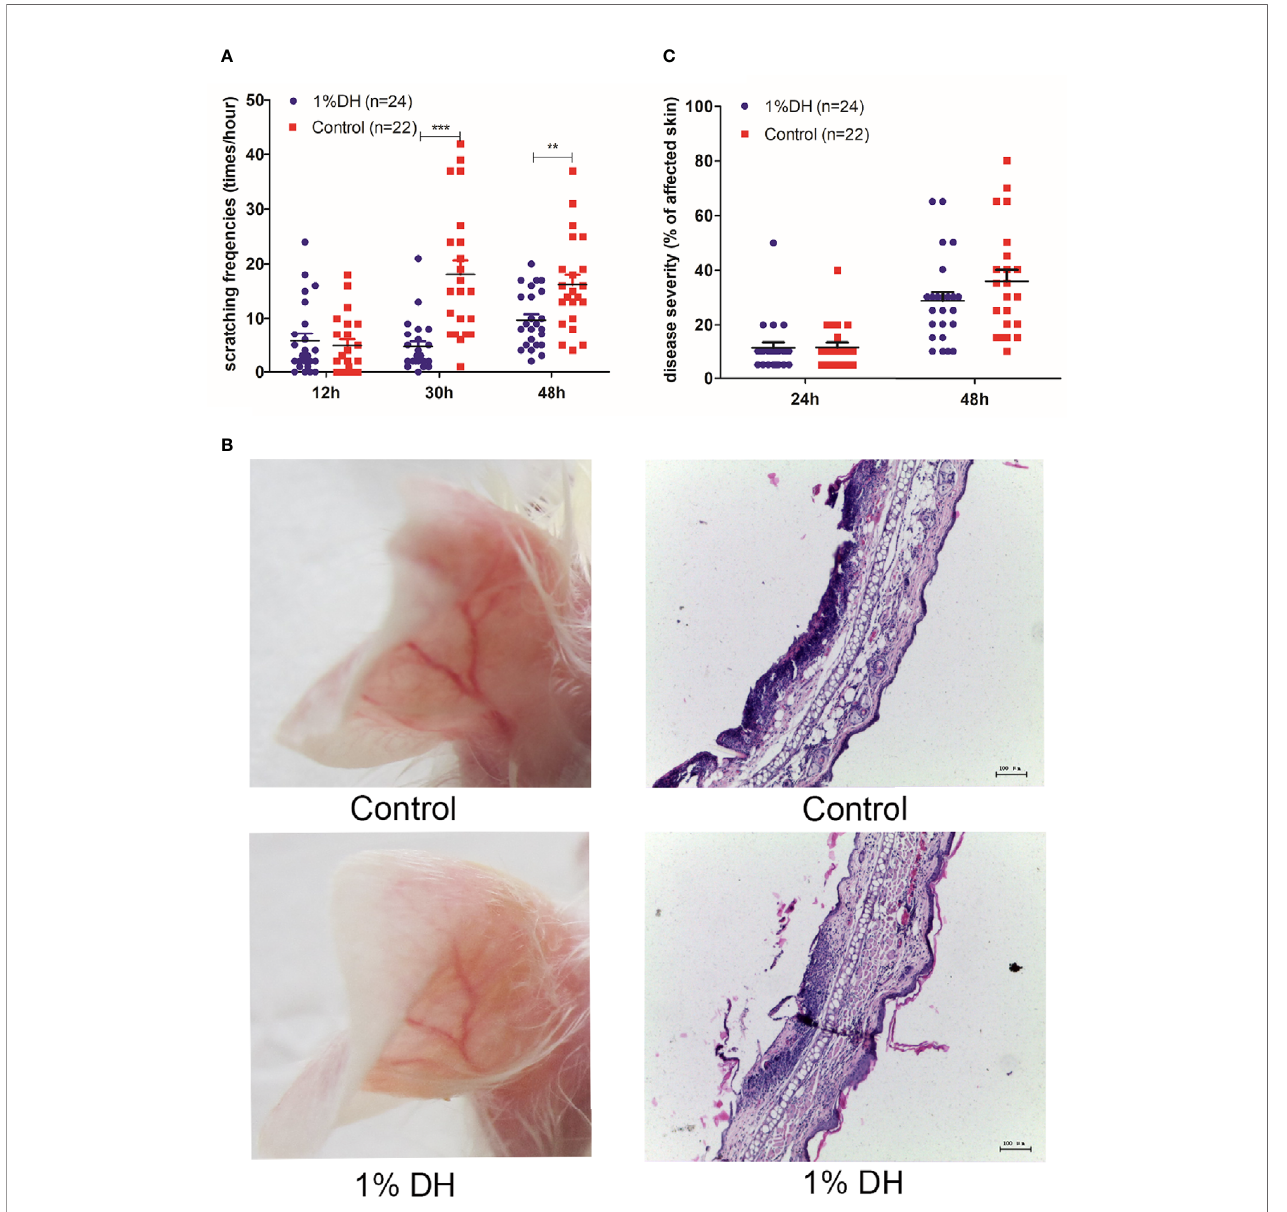
FIGURE 3 | Therapeutic topical application of dyclonine improved itch, but had no impact on clinical disease manifestation in antibody transfer-induced EBA. Twenty-four hours after the injection of anti-mCOL7 IgG, mice were divided into two groups with equal mean value of disease severity. The 1% dyclonine or solvent were applied topically onto mouse ears, respectively, and such application was maintained every six hours until the end of experiment. (A) Effect of dyclonine on scratching behaviour at 12, 30 and 48 h after the injection of anti-mCOL7 IgG. (B) Representative pictures of skin lesions and histology of ear skin in mice injected with rabbit anti-mCOL7 IgG and treated with dyclonine hydrochloride or control solvent. (C) Effect of dyclonine hydrochloride on disease severity at 24 and 48 h after the injection of antibodies. This fi gure shows results derived from 2 independent experiments.In total, 12 mice (24 ears) treated with 1% dyclonine and 11mice (22 ears) treated with control solvents were used for analysis. Bars, 100 m m. Signi fi cant differences as determined by unpaired student t test between anti-mCOL7 IgG- treated ears and control IgG-treated ears are indicated (** p < 0.01, *** p <